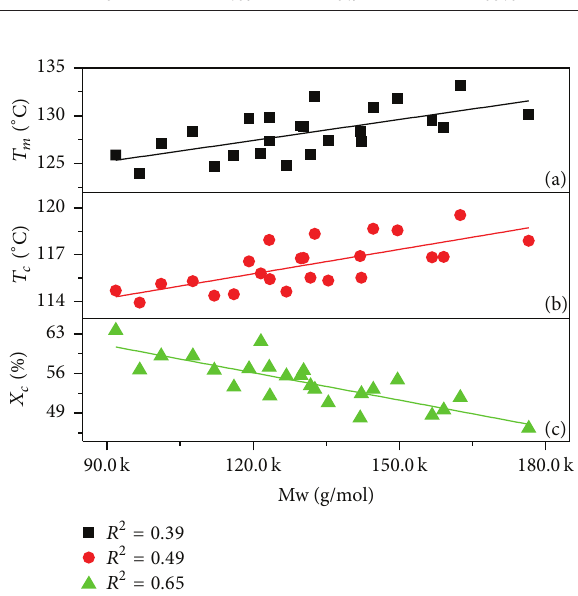
Figure 6: Correlation plots of MW with Tm (a), Tc (b), and %Xc